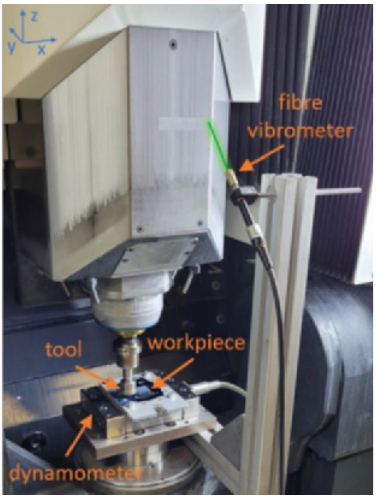
Fig. 1. Preliminary measurement set-up including vibrometer and dynamometer measuring devices